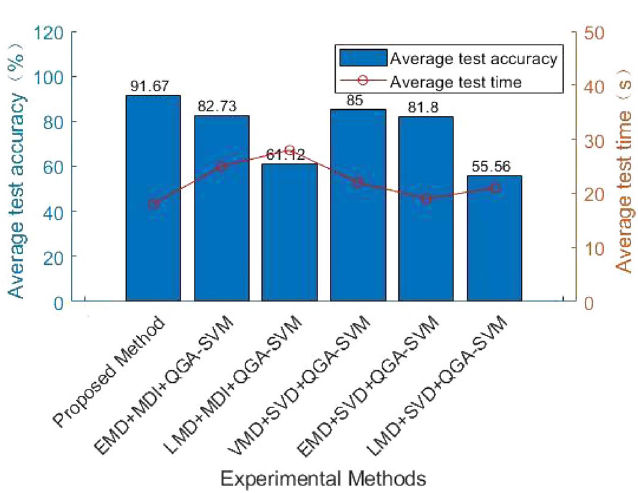
Figure 10. Comparison of different feature extraction methods.